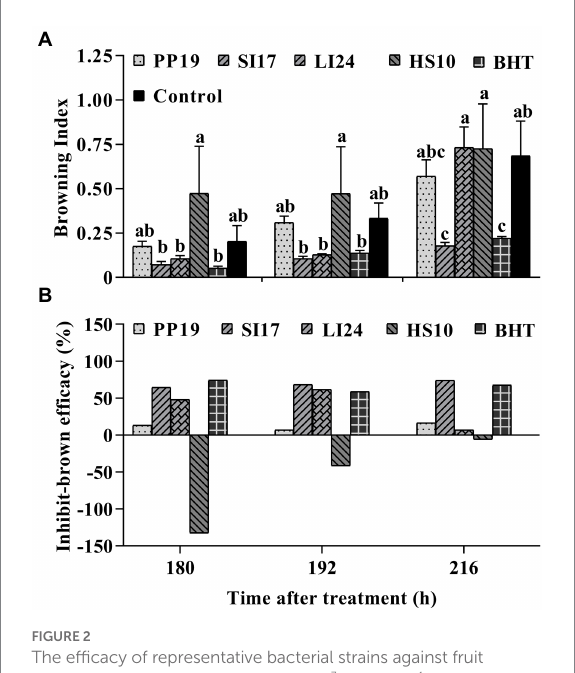
FIGURE 2 The efficacy of representative bacterial strains against fruit browning in FLT2017-1. Bacteria (5 × 10 7 CFUs mL − 1 ) were sprayed on cv. ‘Feizixiao’ (65% ripeness, Danzhou, Hainan Province) in the field, and fruits (about 80% ripeness) were picked and placed in a preserving box in the laboratory after 7 days. Browning indices of preharvest litchi fruit treated with the four strains PP19, SI17, LI24, and HS10, and the BHT and LB broth controls (A) . The browning inhibition efficacies are shown in panel (B) . Data are presented as means of replicates ± standard errors; different letters indicate significant differences between treatments according to LSD test at p < 0.05.